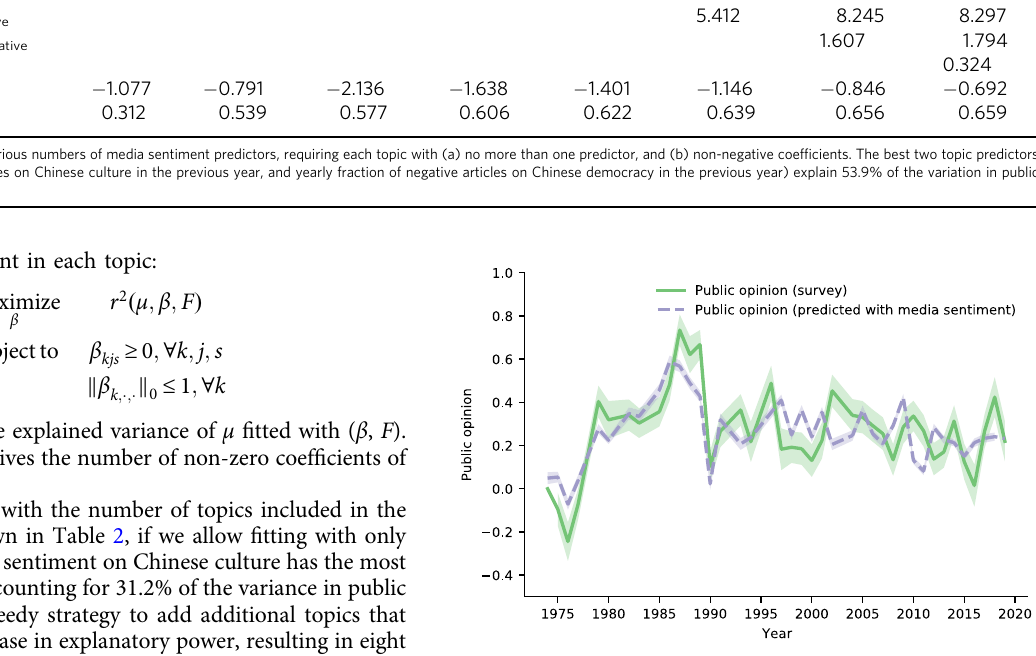
Fig. 4 Regressing public opinion of Americans toward China on The New York Times sentiments. The public opinion (solid), as a time series, is well fi tted by the media sentiments on two selected topics, namely “ Culture ” and “ Democracy ” , in the previous year. The dashed line shows a linear prediction based on the fractions of positive articles on “ Culture ” and negative articles on “ Democracy ” in the previous year. The public opinion is shown with a 95% con fi dence interval, and the fi tted line is shown with one standard